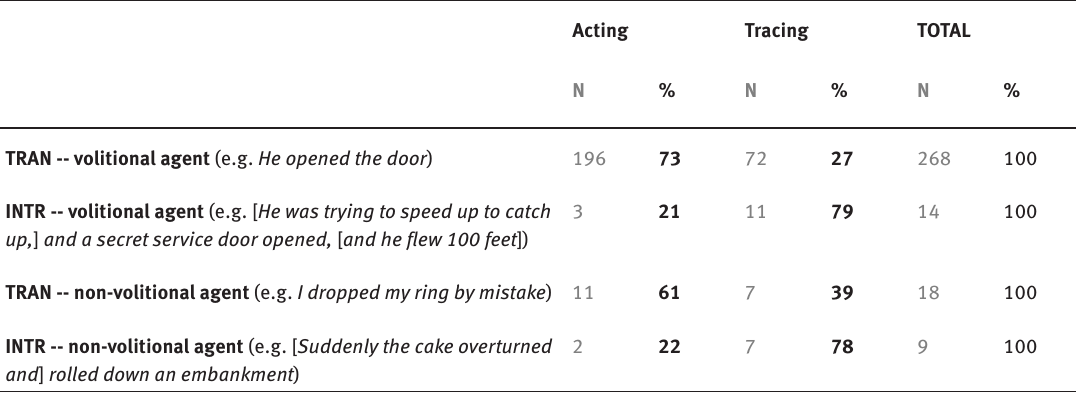
Table 5. Gestural Modes of Representation with respect to the causative-inchoative alternation with volitional or non-volitional agent as external